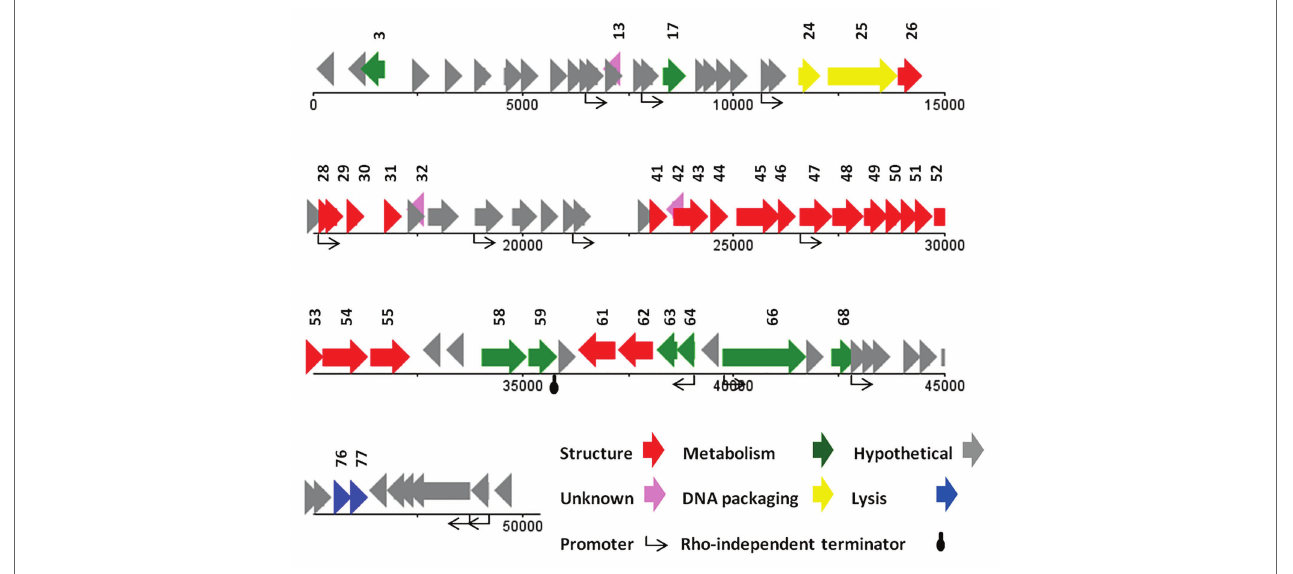
FIGURE 6 | The linear genome map of phage